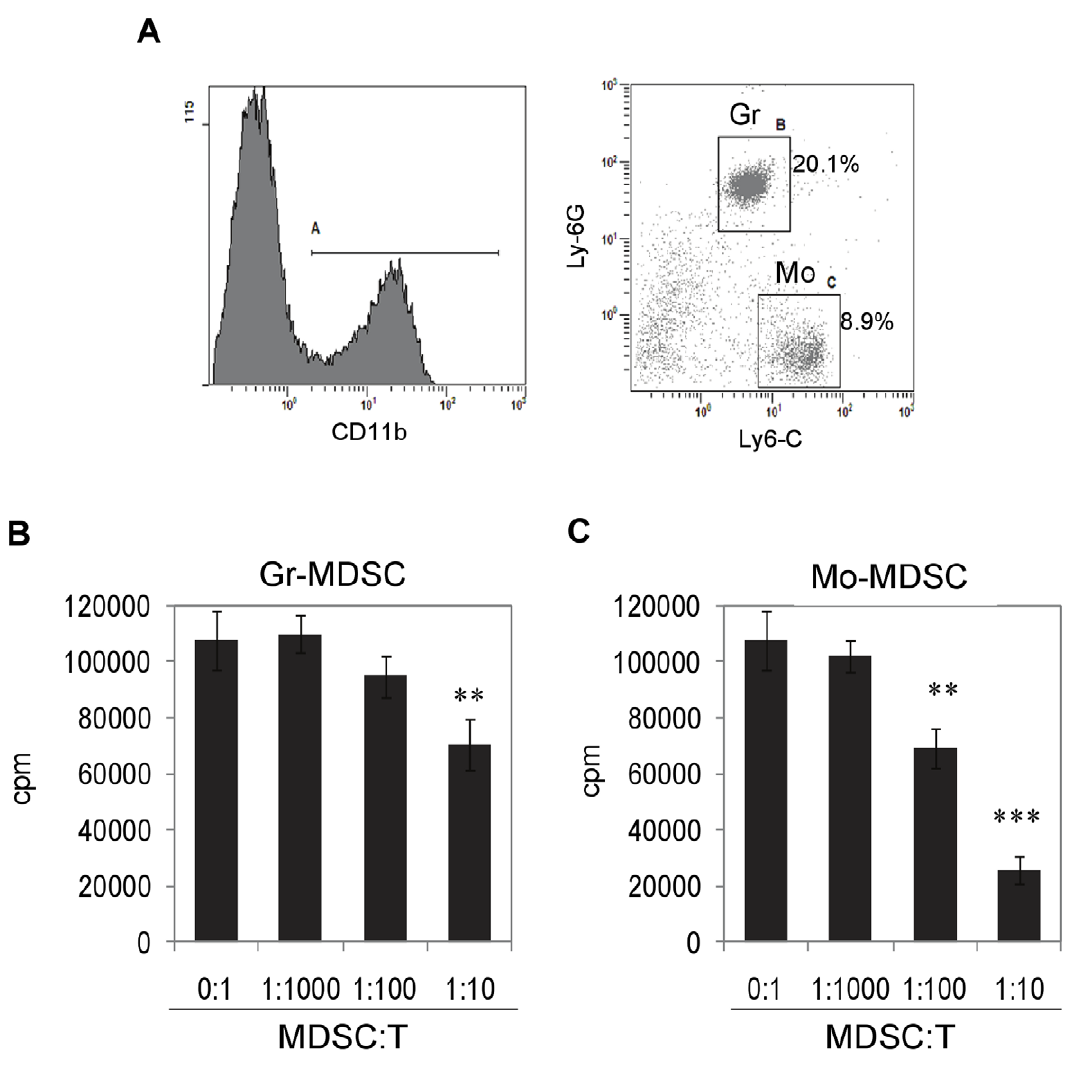
Figure 7. Identification of MDSC subsets induced by CBD in liver and their suppressive activity. Liver infiltrating cells were isolated from ConA + CBD injected mice at 12 h. Cells were triple-stained for CD11b, Ly6-G and Ly-6C, and analyzed by FACS. A) Cells were gated for CD11b + expression (histogram) and further analyzed for Ly6-G and Ly6-C antigens (dot plot). Representative dot plot shows percentages of CD11b + Ly6- G + Ly6-C + granulocytic MDSCs (Gr-MDSC) and CD11b + Ly6-G – Ly6-C + monocytic MDSCs (Mo-MDSC). B & C) MDSC subsets were purified by FACS sorting and used in T cell proliferation assay in vitro at different ratios with syngenic purified T cells stimulated with ConA. T cell proliferation was assessed by [3H]thymidine incorporation at 48 h. T cells cultured without MDSCs and with ConA served as the positive control. Data are mean 6 SEM for